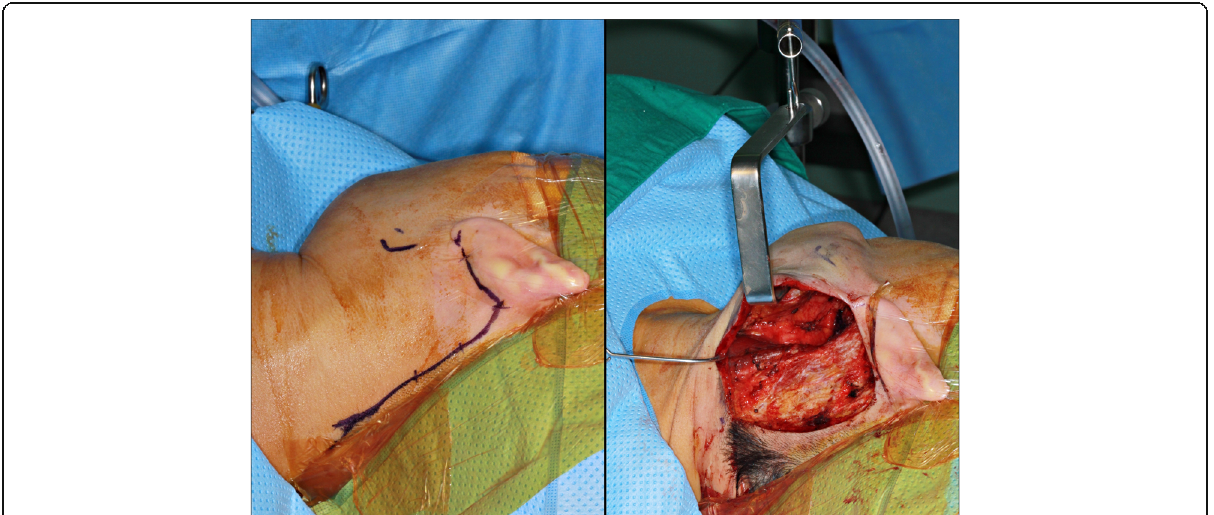
Fig. 3 Modified facelift incision (MFI) for robot-assisted submandibular gland excision ( left ) and obtaining a sufficient amount of working space (approximately 10-cm height) for securing a self-retaining retractor ( right )